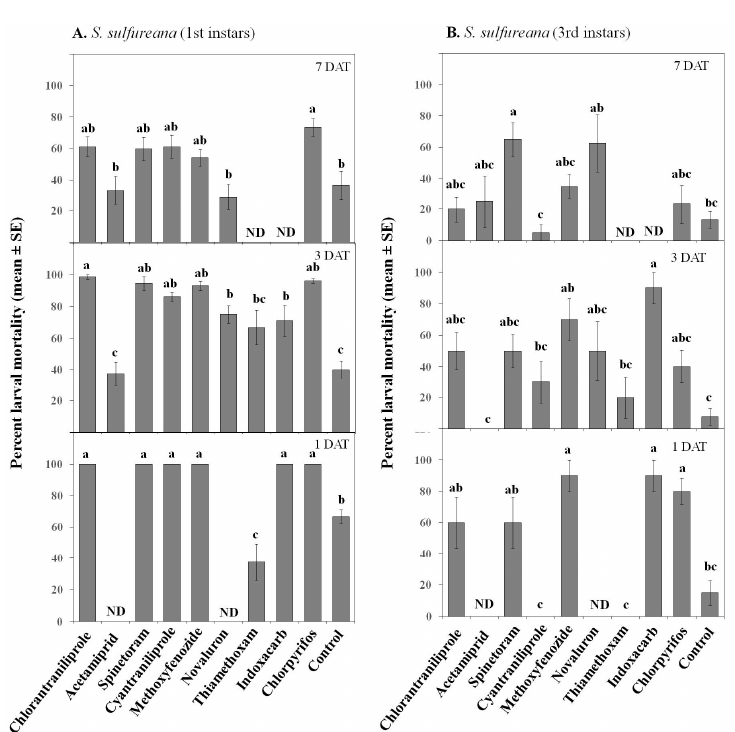
Figure 6. Effect of various insecticides on Sparganothis sulfureana 1st ( A ) and 3rd ( B ) instar larvae after exposure to 1, 3, and 7 DAT field-aged residues. DAT = days after treatment. ND = not determined. Bars with the same letter are not significantly different at α = 0.05.